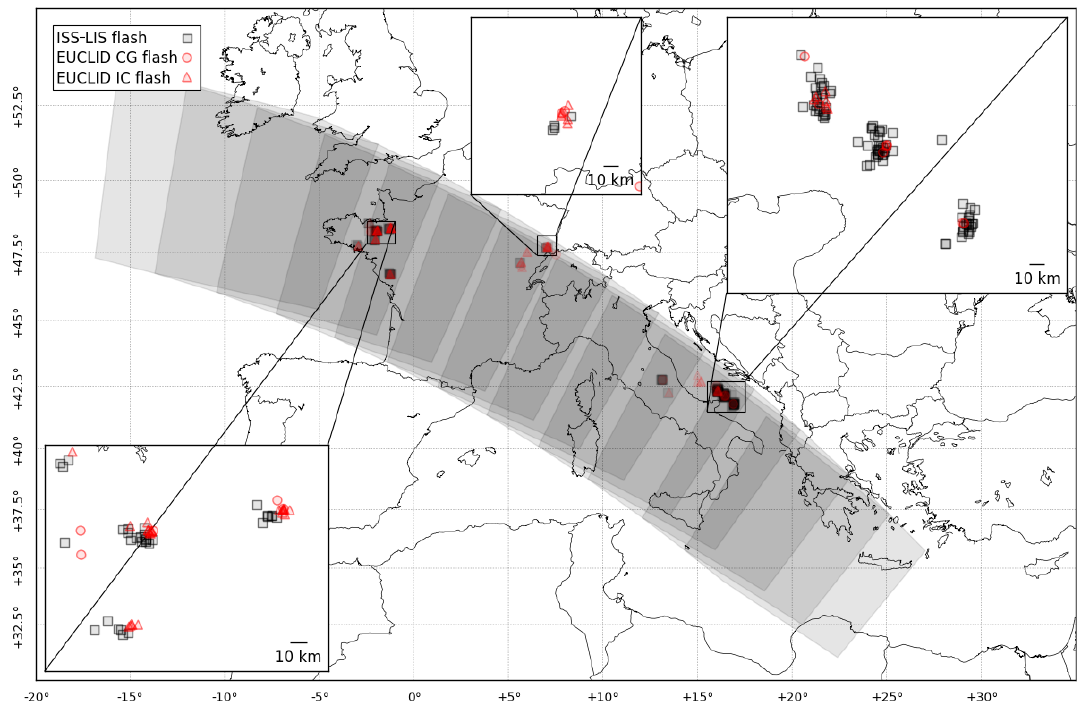
Figure 2. Example of an ISS-LIS track over Europe with the LIS field of view at distinct time steps indicated in gray. Lightning flashes observed by the ISS-LIS are displayed as well as the CG and IC flashes detected by EUCLID.